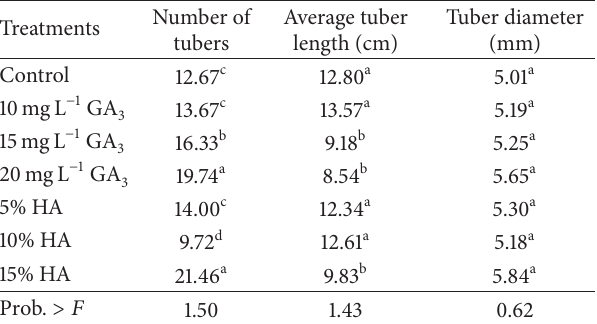
Table 6: Morphological characteristics of tubers as affected by different treatments.